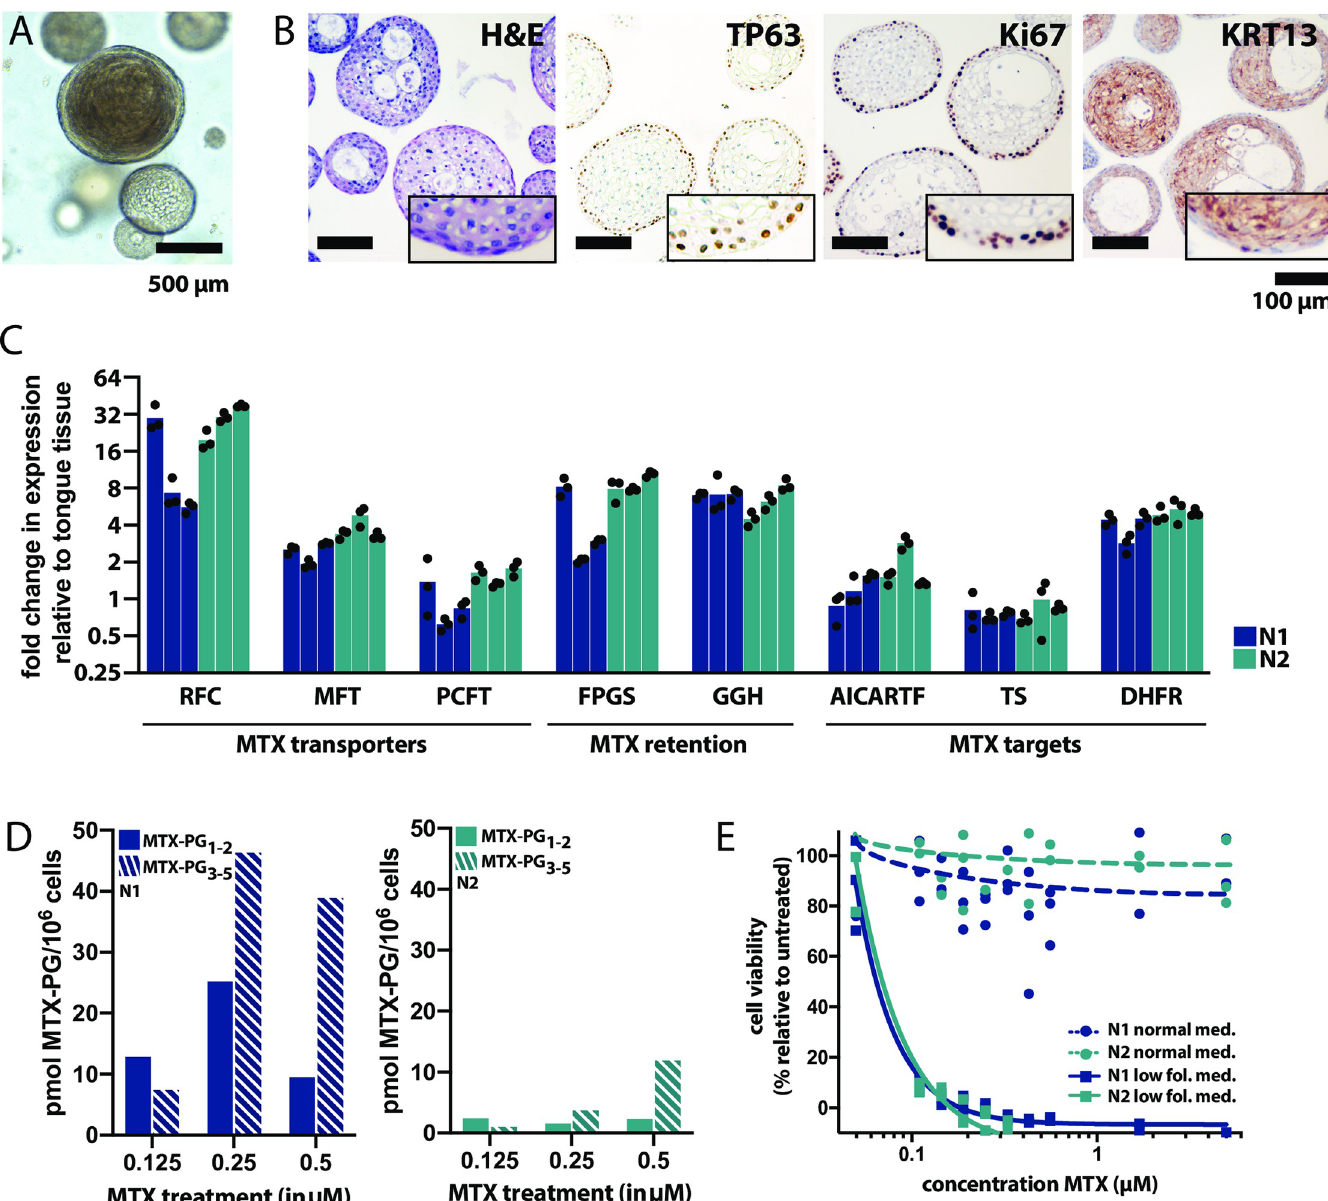
Fig 1. Human normal oral mucosa organoids can be used to model MTX-induced toxicity in vitro . A. Morhpology of oral mucosa organoids, brightfield microscopy. The cells form round structures with keratinized centers. Scalebar, 500 μ m. B. Immunohistochemical stainings performed on paraffin-embedded oral mucosa organoids indicate that organoids resemble the histological characteristics of in vivo oral mucosa epithelium, with a layer of proliferating basal cells (P63/KI67+) on the outside in contact with the BME (an in vitro basal lamina mimetic) and more differentiated (KRT13+) cells on the inside of the organoids. Hematoxylin and eosin, TP63 staining, KI67 staining and KRT13 staining are shown from left to right. Scalebar, 100 μ m. C. Expression of genes involved in MTX transport, metabolism and toxicity was quantified in low folate medium using quantitative qPCR. Allgenes tested were expressed at detectable levels in oral mucosa organoids. D. Short chain MTX-PG 1-2 (dashed bars)and long-chain MTX-PG 3-5 (filled bars) accumulation in two oral mucosa organoid cultures (N1 blue, N2 green) exposed to increasing doses of MTX (0.125, 0.25 and 0.5 μ M respectively), detected by UHPLC-MS/MS. E. MTX exposure induces toxicity (cell death) in oral mucosa organoids grown in low folate medium, but not in normal oral mucosa medium that was previously described in Driehuis et al [38]. Organoids were exposed for five days to MTX and viability was quantified relative to untreated organoids. Reproducible killing at physiological doses of MTX was observed in low folate medium only (dashed lines, circle data points), not in normal organoid medium (continuous lines, square data points).